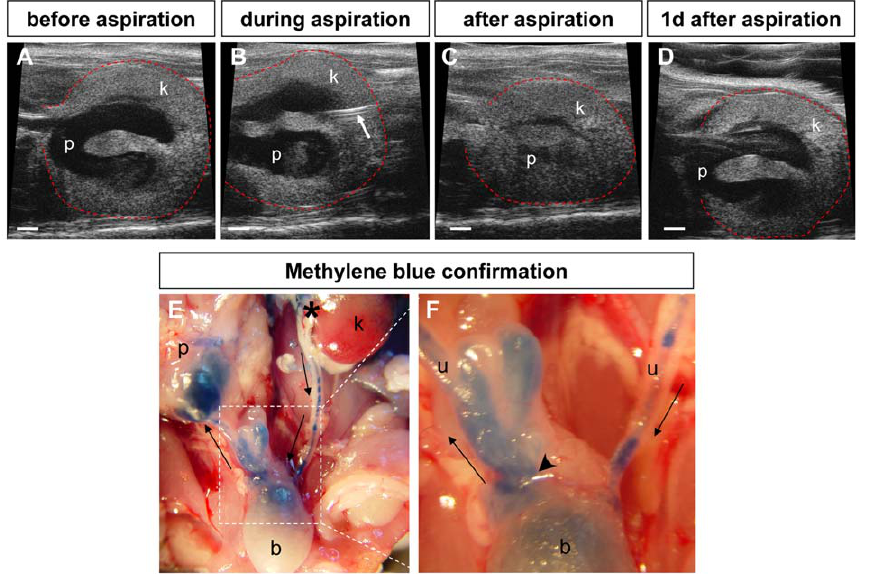
Figure 5. Causal relationship of hydronephrosis and VUR in Robo2 mosaic mice. Unilateral hydronephrosis were exacerbated by the retrograde flow of urine from the contralateral functional kidney. ( A – D ) Ultrasound-guided percutaneous aspiration of urine from the right renal pelvis of a Robo2 mosaic mouse with severe unilateral hydronephrosis: (A) right renal pelvis with hydronephrosis before ultrasound-guided needle insertion; (B) ultrasound-guided needle (arrow) insertion; (C) collapsed right renal pelvis after ultrasound-guided needle aspiration; (D) reappeared right hydronephrosis one-day after aspiration. p, pelvis; k, kidney. ( E , F ) Methylene blue dye tracing showing retrograde flow of urine refluxing into the right renal pelvis from contralateral functional left kidney after methylene blue injection into the left renal pelvis; asterisk in (E) marked the methylene blue injection site in the left renal pelvis; arrows indicated the direction of urine flow that was labeled by methylene blue. (F) High magnification of boxed ureterovesical junction region in panel (E) showing abnormal enlarged right ureteral orifice (arrowhead) which disrupted the anti-reflux mechanism and allowed ureteral reflux to occur.